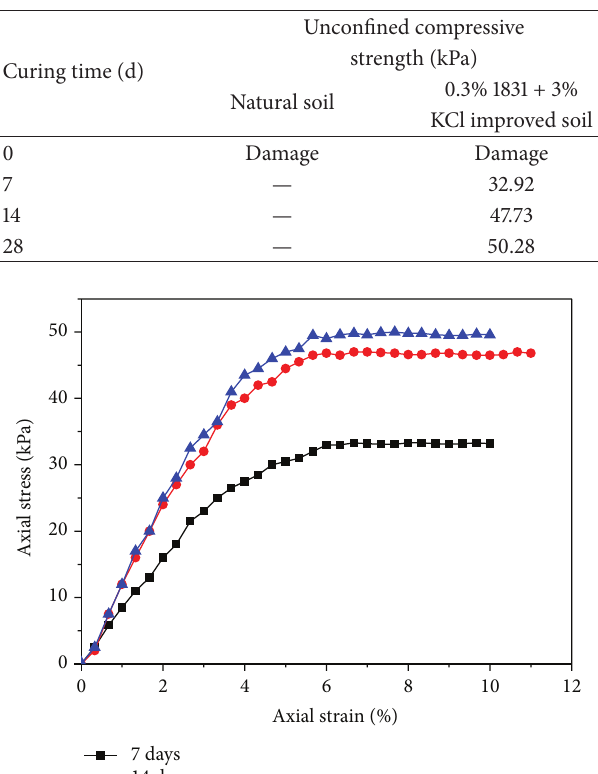
Table 2: Free swell rate of improved soil. Table 3: Unconfined compressive strength of untreated and treated soil under different curing periods.